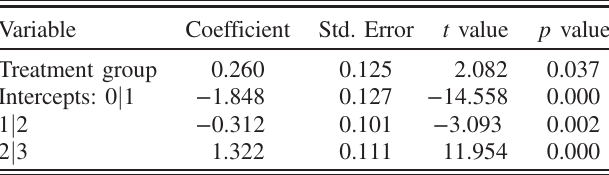
TABLE III. Results of an ordered logistic regression model of rubric score versus presence in the treatment group. Variable